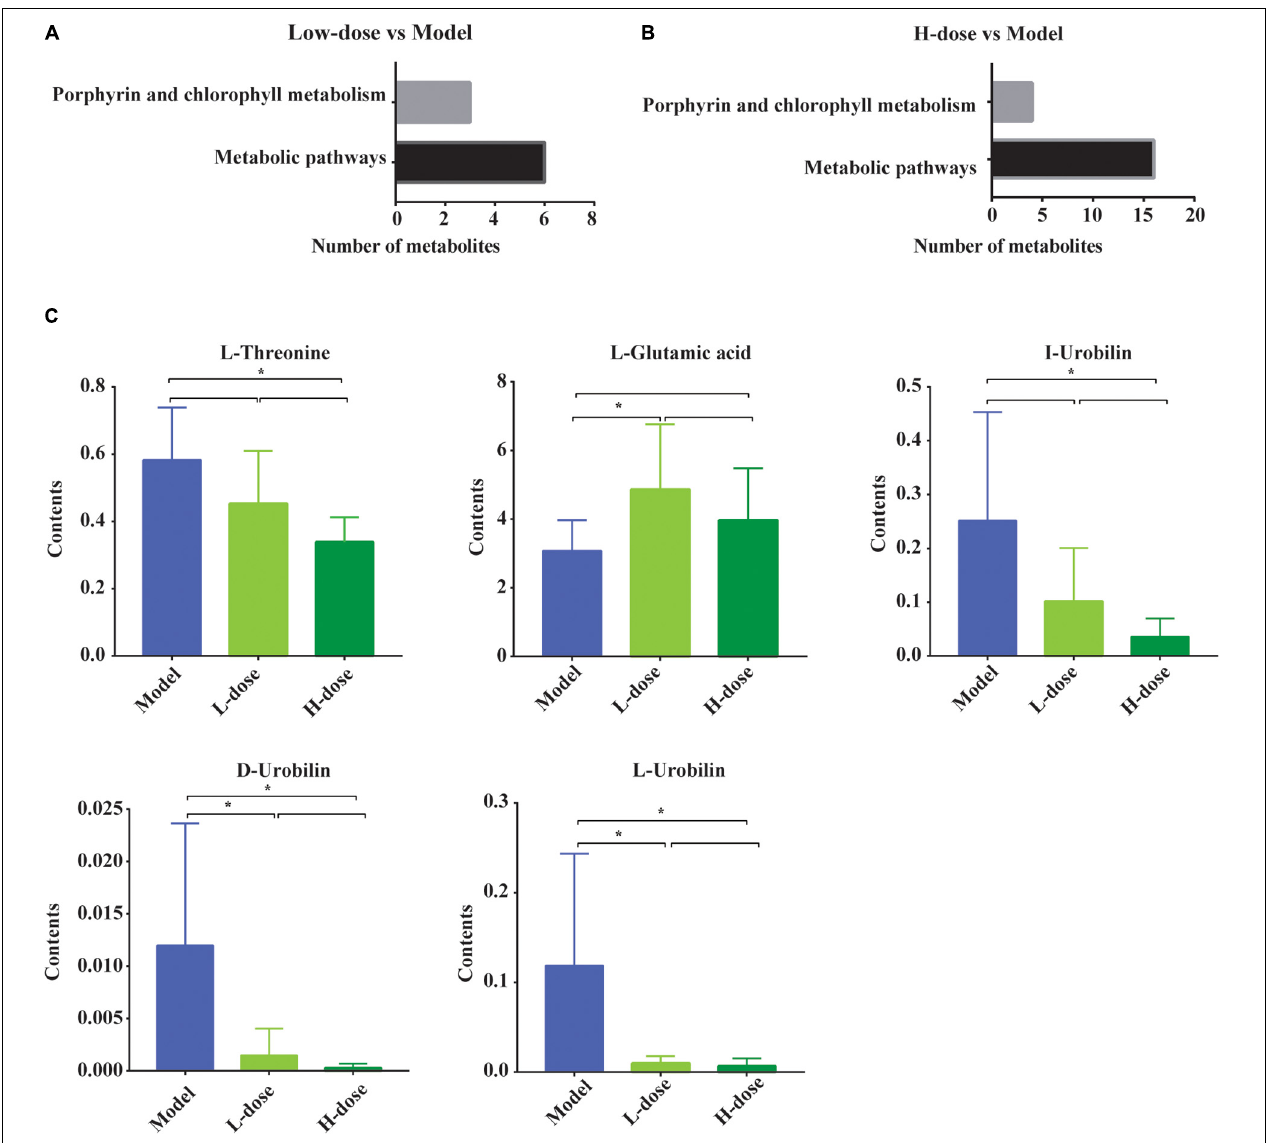
FIGURE 5 | The changed gut metabolites and pathways in GDM rats treated with probiotics. (A,B) The porphyrin and chlorophyll metabolism pathway and metabolic pathway in KEGG Database. (C) The comparison of gut metabolites which participated in porphyrin and chlorophyll metabolism pathway and metabolic pathway by the post-hoc test or non-parametric test. * P <